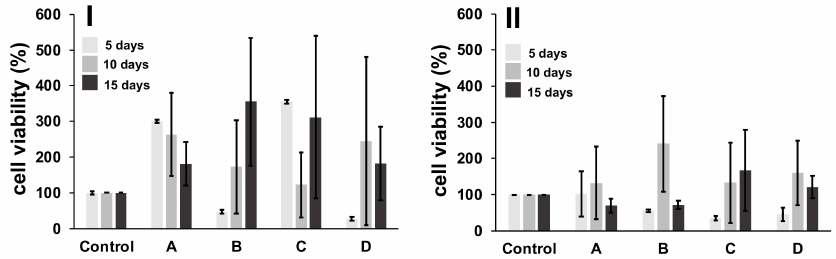
Figure 12. MTT assay for cells after contact with 3D-printed/electrospun ellipsoidal ( I ) and square ( II ) composites. A control sample is a composite prepared without cover over the surface of 3D-printed pieces with fibers; and A-D are those prepared with PLA-based fibers: (A) PLA10, (B) PLA/PEG,